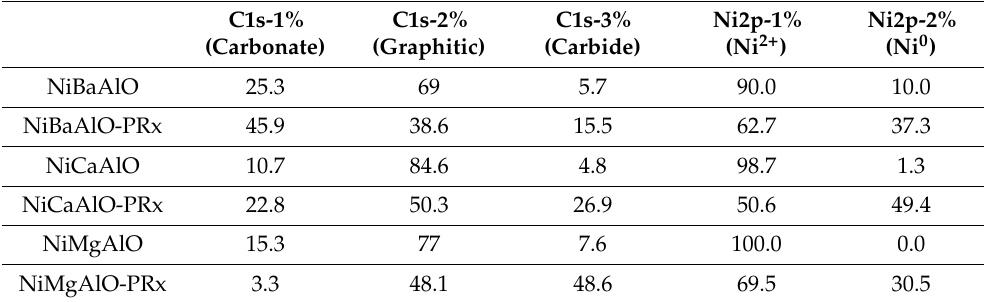
Table 4. Calculated surface % area for the indicated elements obtained from XPS and peaks maxima for NiBaAlO, NiMgAlO, and NiCaAlO samples.